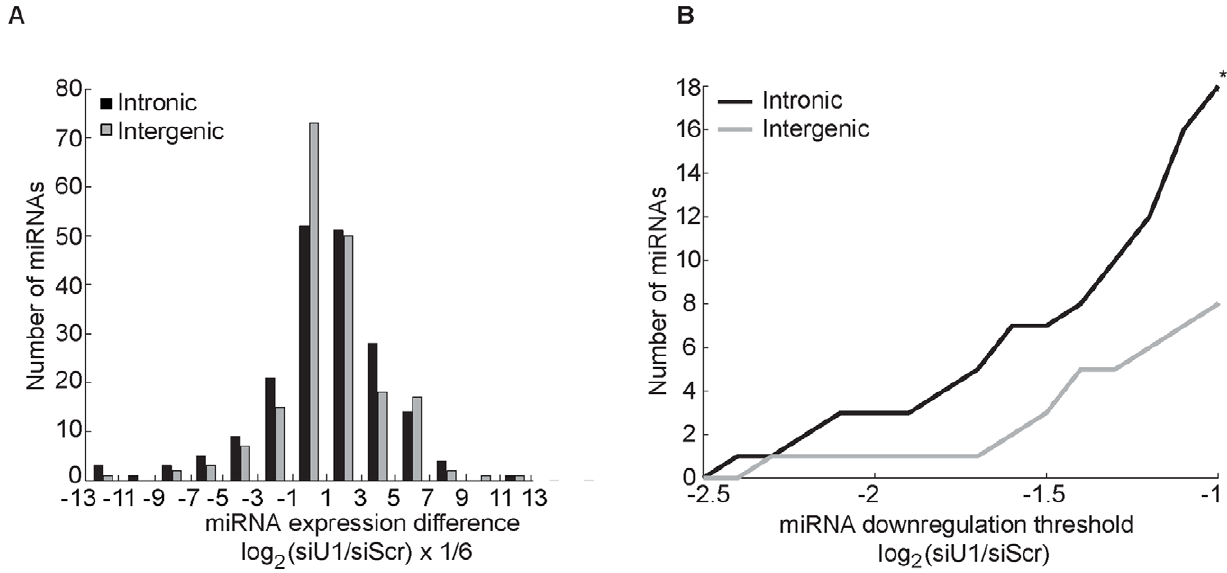
Figure 4. Knockdown of factors in the 5 9 SS recognition complex U1 globally decreases intronic miRNA levels. (A) Human melanoma cell lines, 451LU and 501mel, were transfected with either Scr or U1-specific (SNRNP70 + PRP8) siRNAs, and total RNA was extracted and subjected to miRNA expression profiling. The effect of U1 depletion on 192 intronic (black bars) and 190 intergenic (gray bars) miRNAs detected in either cell line is represented as a histogram with the number of miRNAs on the y-axis plotted as a function of the normalized log 2 difference in the levels between control and U1 depletion on the x-axis. The x-axis bins sizes are 1/3 of a unit; the bins are centered at log 2 fold change of 0, + 2 1/3, + 2 2/3,…. (B) Total number of intronic and intergenic miRNAs (y-axis) graphed as a function of fold down-regulation (x-axis). 18 intronic and 8 intergenic miRNAs were down-regulated by more than 2 fold (log 2 (siU1/siScr) ,2 1; p , 0.05).